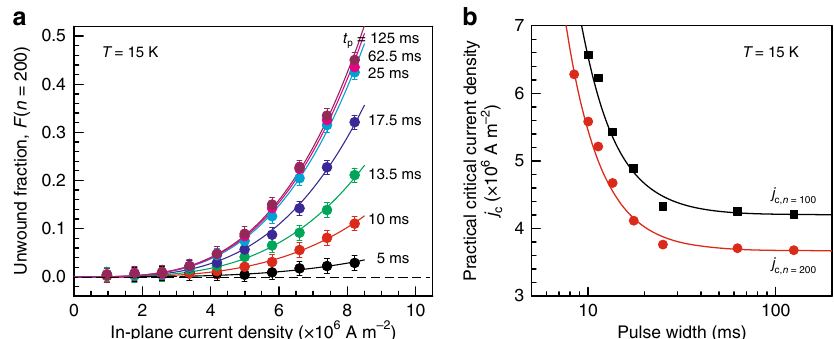
Fig. 6 Pulse-width dependence of the critical current density. a The topologically unwound fraction of the written metastable SkS-L after the application of 200 in-plane pulses, F ( n = 200), with varying current density, j , and pulse width, t p . The curves are fi ts to the power low with a fi xed exponent, F ( n = 200) ~ j 3.4 . The error bars are derived from the uncertainty about the measured ρ yx values corresponding to ± 0.4 n Ω cm. b Practical critical current density vs. pulse width. j c, n = 100 and j c, n = 200 denote the current density at which F ( n = 100) and F ( n = 200), respectively, are equal to 0.03 at a given pulse width. Black and red lines are fi ts to the power law, j c, n − j c, n ( t p → ∞ )~ t p – 1/ δ , with δ = 0.43. Measurements were performed at 15 K and Δ ρ fi les for t ≥ 25 ms, see Supplementary Note 2). yx pro p